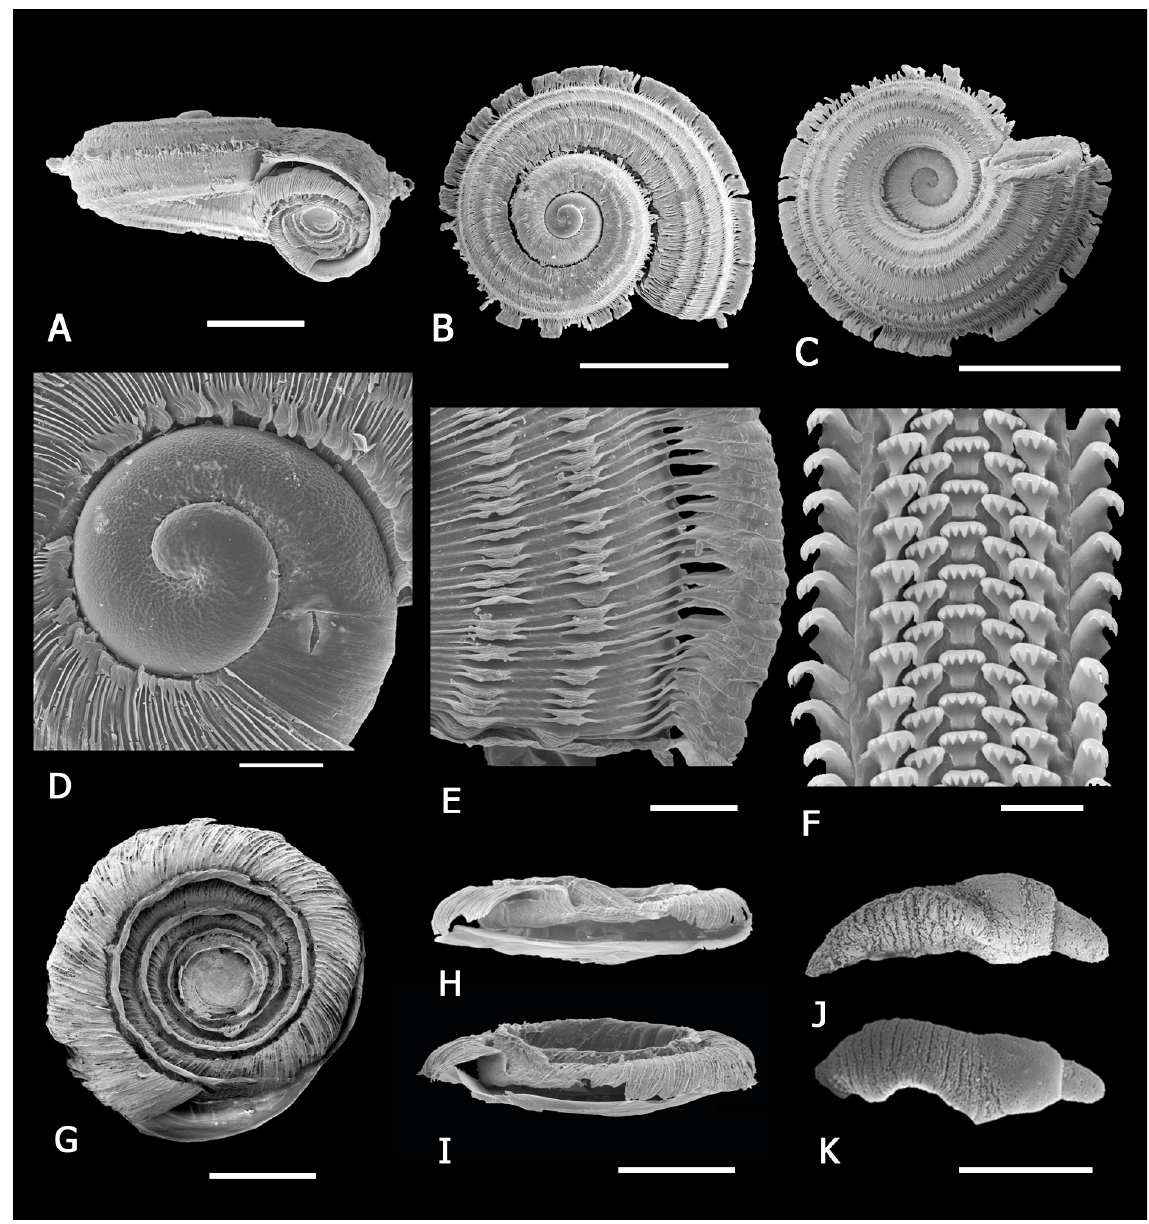
Fig. 19. Chondrocyclus pulcherrimus sp. nov. A–K . ELM W3626/T119. A . Aperture view. B . Dorsal view. C . Ventral view. D Protoconch. E . Detail of axial lamellae of periostracum. F . Portion of radula. G–I . Operculum. J . Penis, lateral view. K . Penis, dorsal view. Scale bars: A–C = 2 mm; D–E = 200 µm; F = 20 µm; G–K = 500